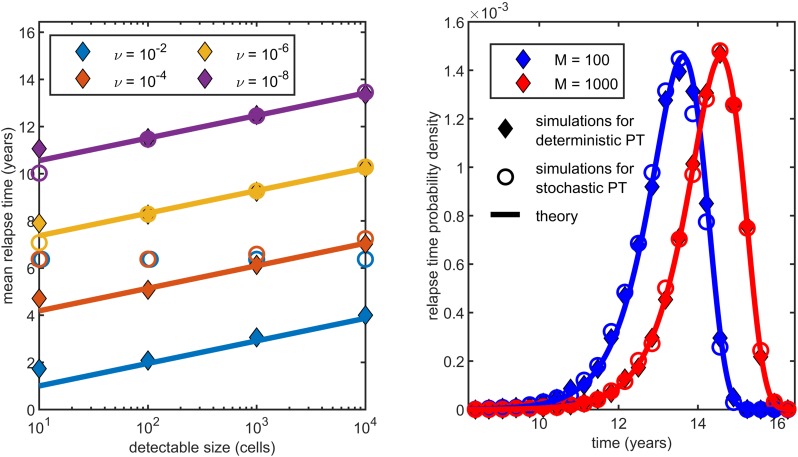
Relapse time distribution for an exponentially growing primary tumor using parameter estimates for colorectal cancer (see Table 2).Symbols represent simulation results for a deterministic (diamonds) or a stochastic primary growth (circles, see Discussion at the end of the parameter estimation section), while solid lines correspond to the theory in the small ν—large M limit. On the left, each starred dot denotes the mean of 1000 simulations, while lines represent the theoretical expectation given by Eq 7. These match the simulated means well for values of ν = 10−6 or less. On the right, the relapse time densities derived from Eq 14 yield a good approximation of the simulated data (10000 simulations per curve) for M = 100 or greater for both deterministic and stochastic primary growth.